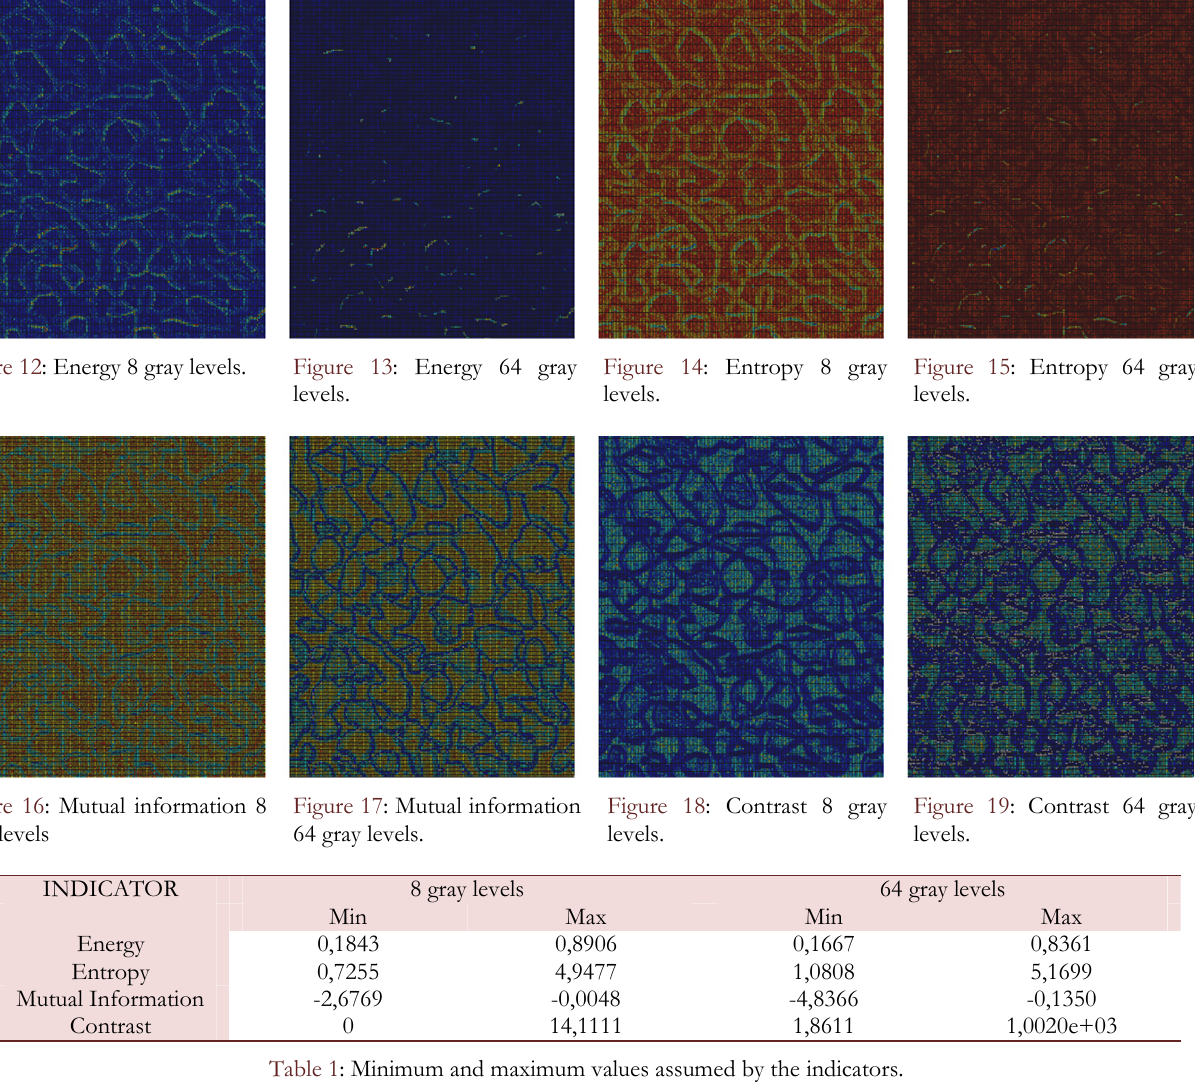
Table 1: Minimum and maximum values assumed by the